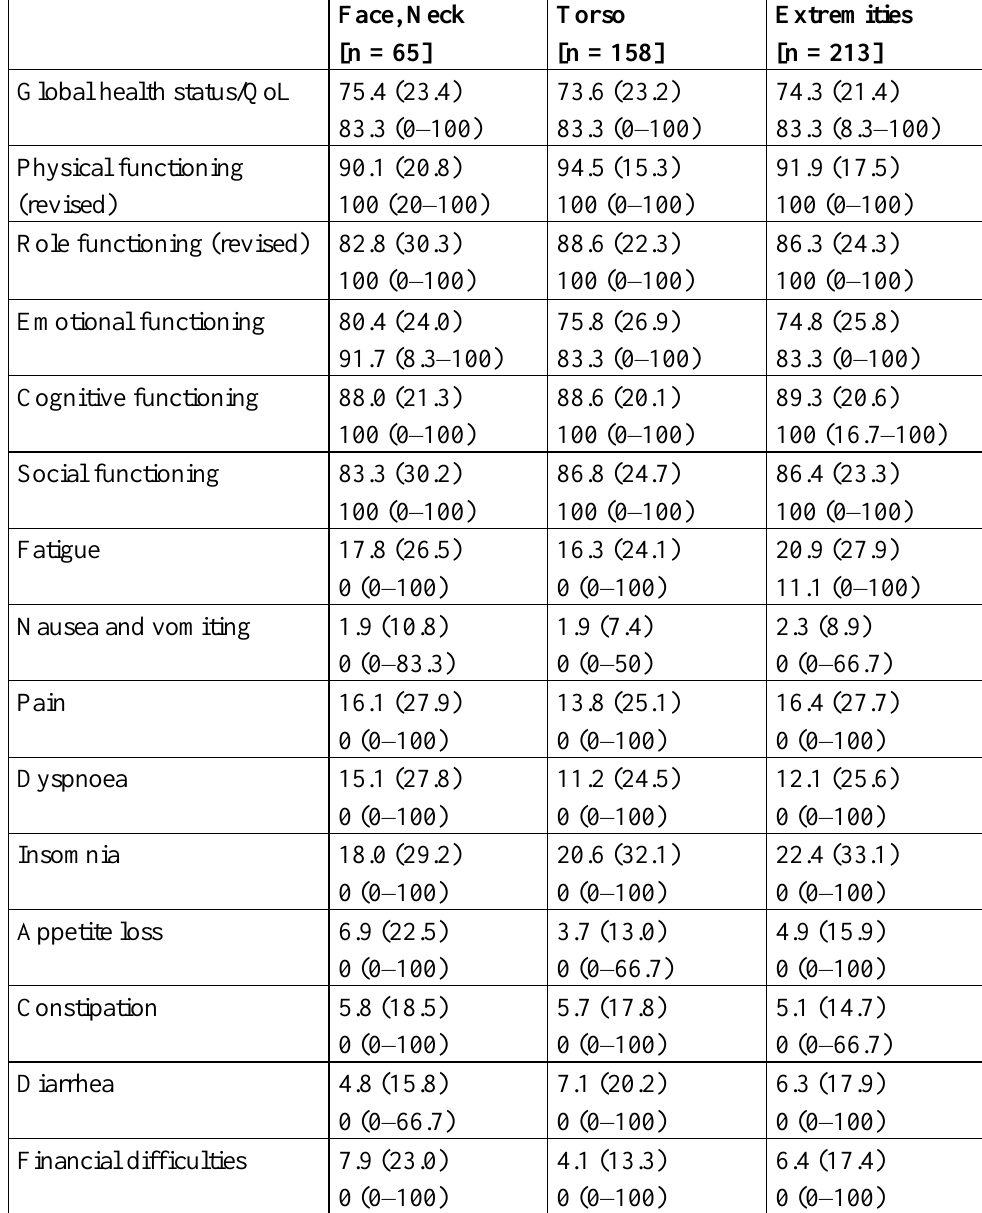
Table 4. Mean (SD) and median (25th–75th percentiles) EORTC QLQ-C30 scores of German melanoma patients at baseline (Q1; OVIS I) according to tumor